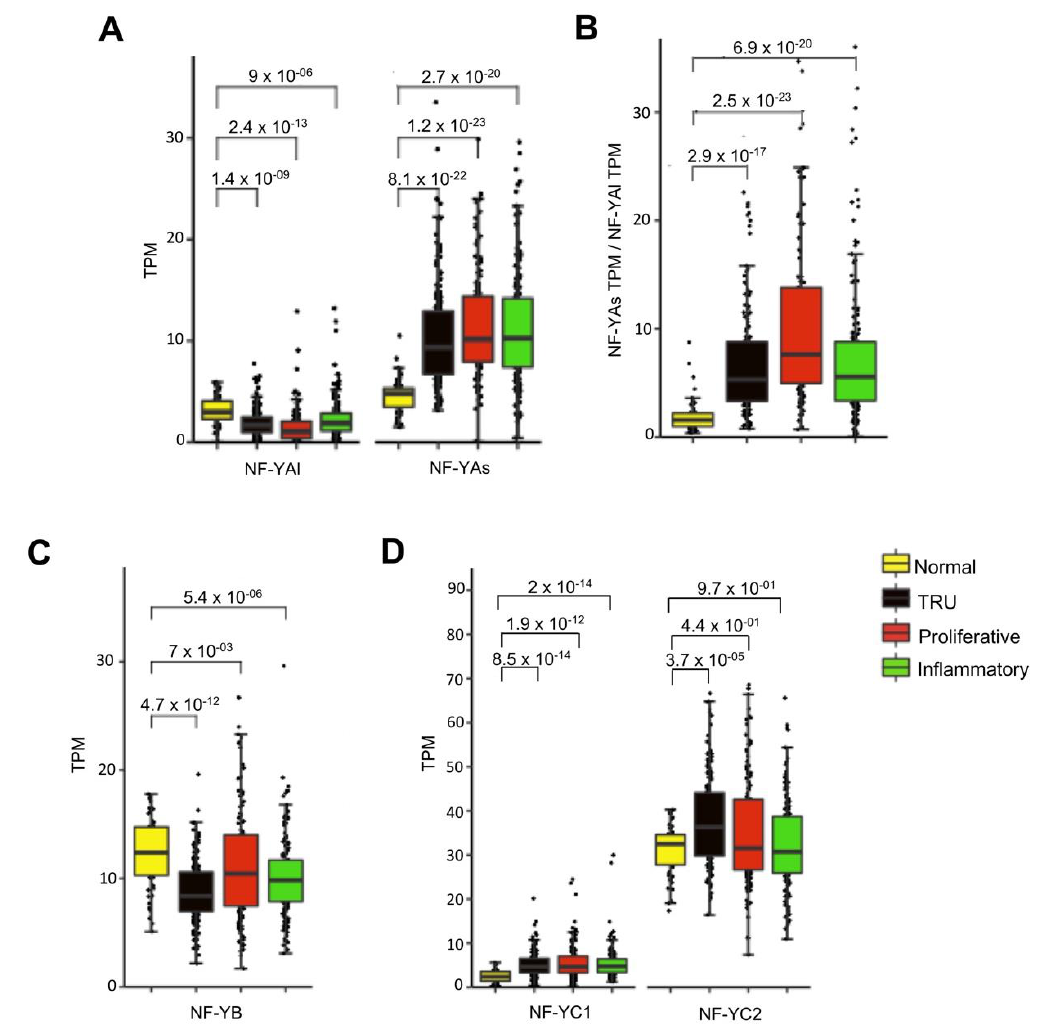
Figure 3. NF-YA was overexpressed in all LUAD subtypes. ( A ) Box plots represent the expression of NF-YA isoforms at gene level in LUAD subgroups, measured in TPM. ( B ) NF-YAs / NF-YAl ratios in the subgroups. ( C ) Same as ( A ), except that expression of NF-YB at gene level is shown. ( D ) Box plots of expression of NF-YC isoforms at gene level in LUAD subgroups. NF-YC1—50 kD isoform. NF-YC2—37 kD isoform. p -values were calculated using a Wilcoxon signed-rank test.